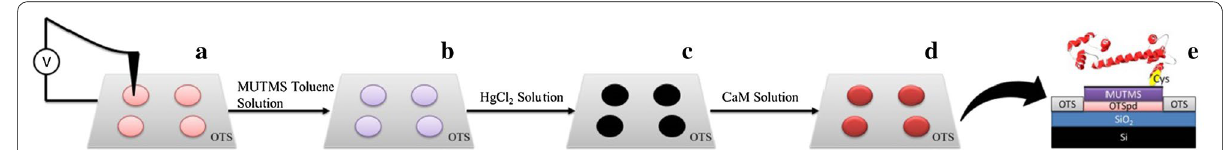
Fig. 2 The Scheme for CaM patterns fabrication. a The OTSpd disk patterns were fabricated by local oxidation lithography. b MUTMS was cross- linked onto the OTSpd patterns, converting the OTSpd patterns into thiol-terminated surfaces. c Substrate was then incubated into HgCl 2 solution to form Hg-SH coupling. d Cysteine-mutated CaM was immobilized on the chemical patterns via cysteine-Hg-SH coupling. e Structural model of substrate corresponding to part ( d